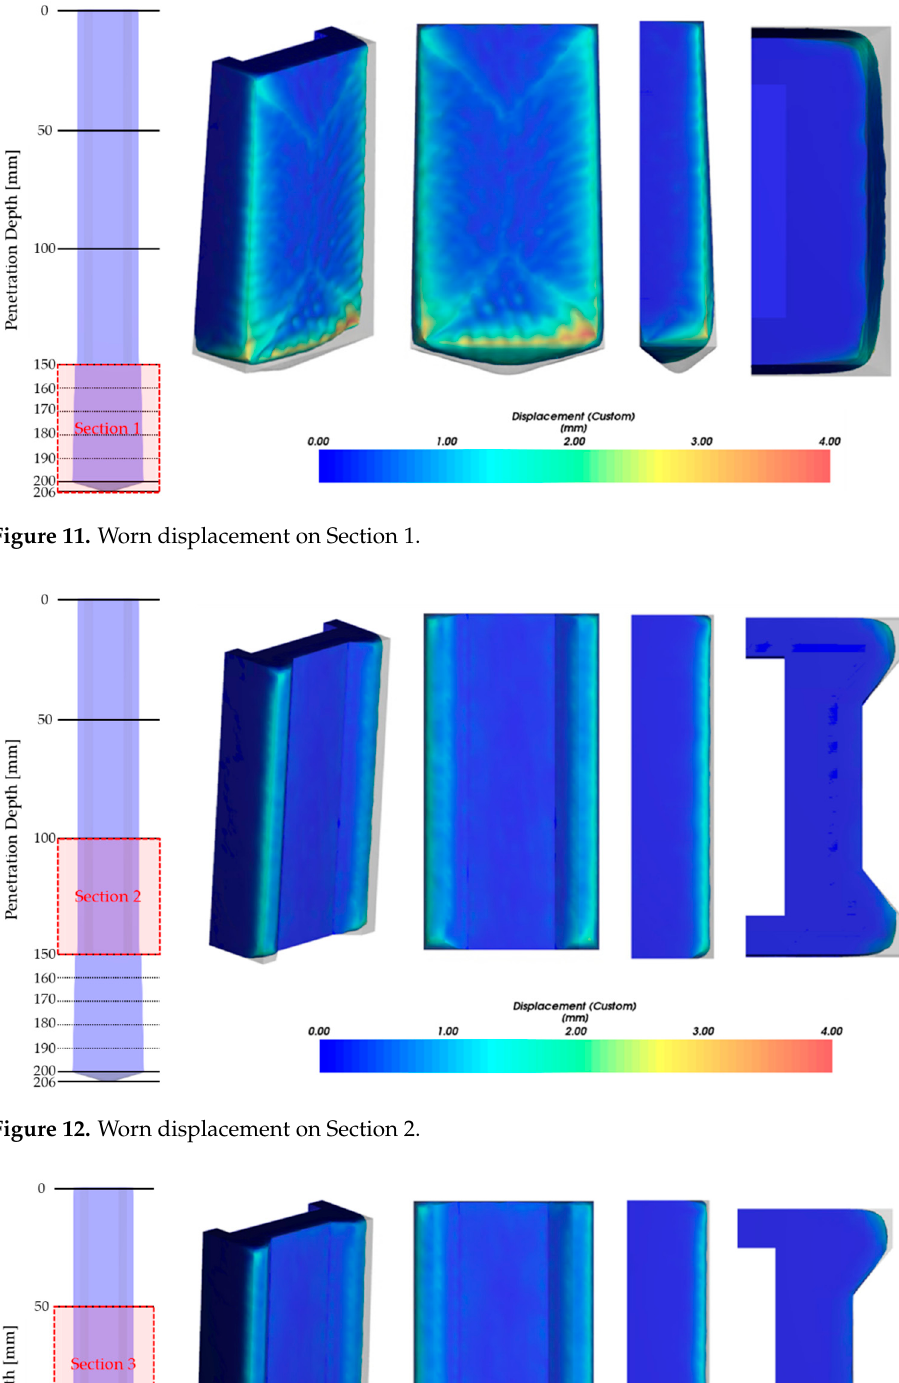
Figure 10. Distribution of worn surface on the surface of specimen predicted by simulation.